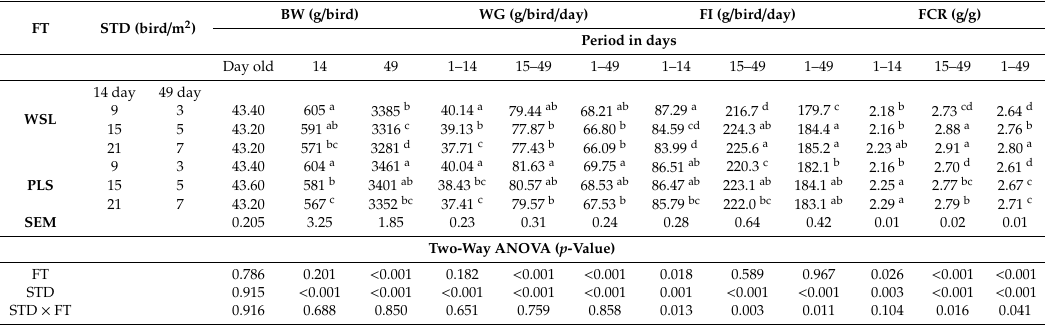
Table 2. E ff ects of stocking density (STD) and flooring type (FT) on body weight, weight gain, feed intake and feed conversion ratio of Pekin ducks.